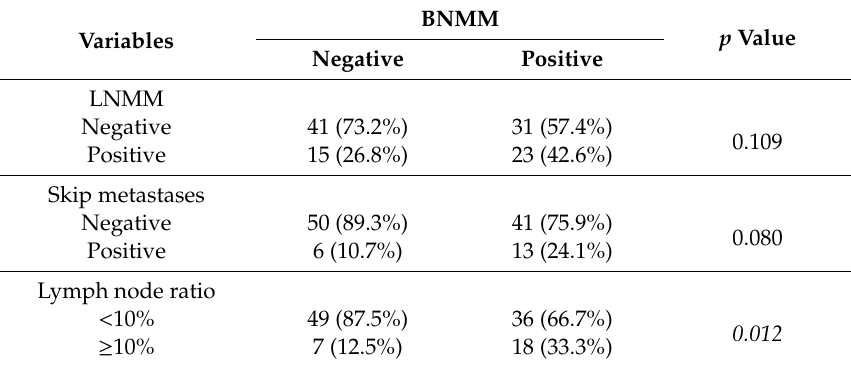
Table 2. Associations between lymph node and bone marrow